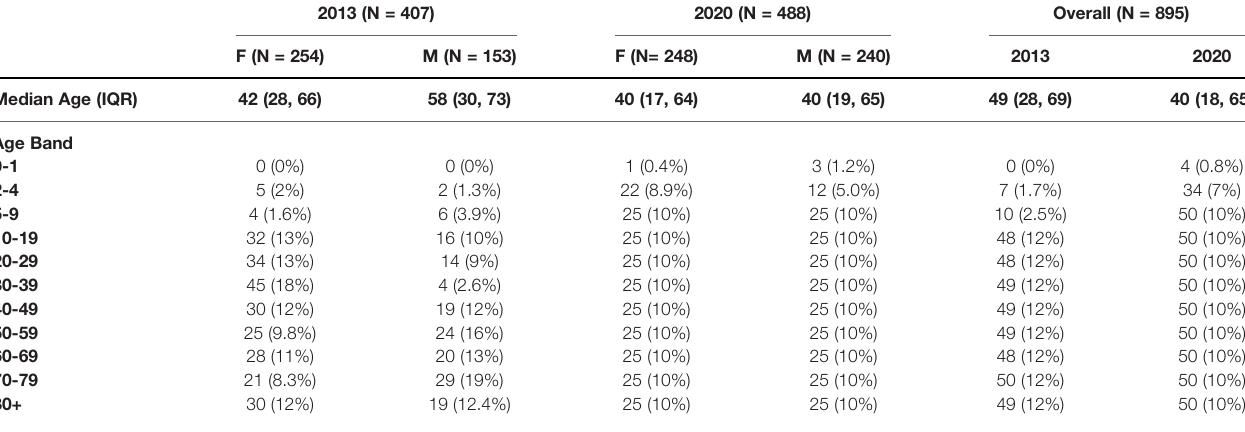
TABLE 1 | Age and sex distribution of study participants from 2013 and